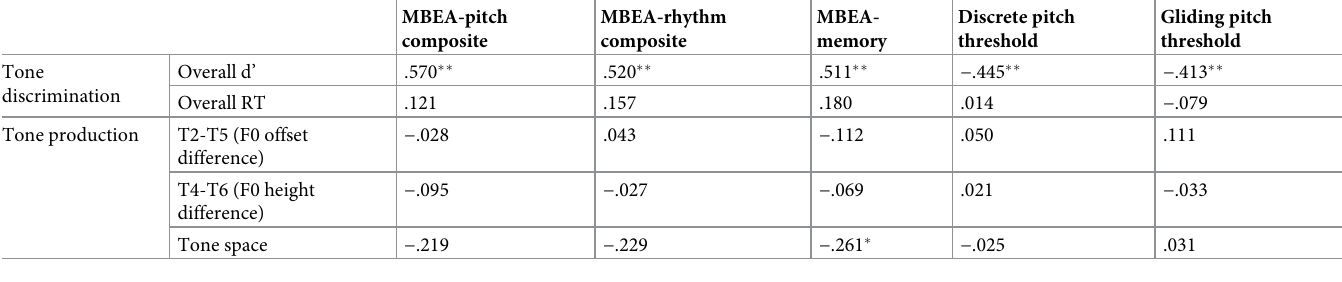
Table 3. Bivariate Pearson correlations (two-tailed) between the musical and pitch abilities (MBEA-pitch, MBEA-rhythm, MBEA-memory, discrete pitch threshold and gliding pitch threshold) and tone discrimination and production performance (the overall d’ scores and overall RT of tone discrimination, and the F0 offset dif- ference of T2-T5, the F0 height difference of T4-T6 and the tone space for tone